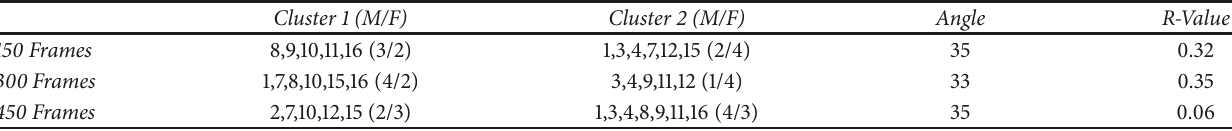
Table 3: Clusters of drivers from HCA including all drivers and all frames.